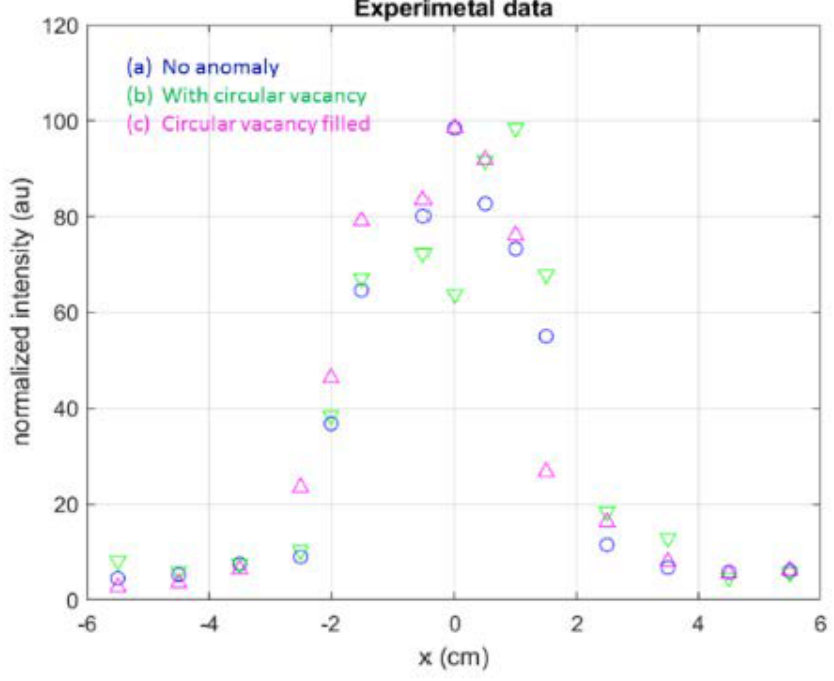
Figure 2. Experimental data normalized to maximum